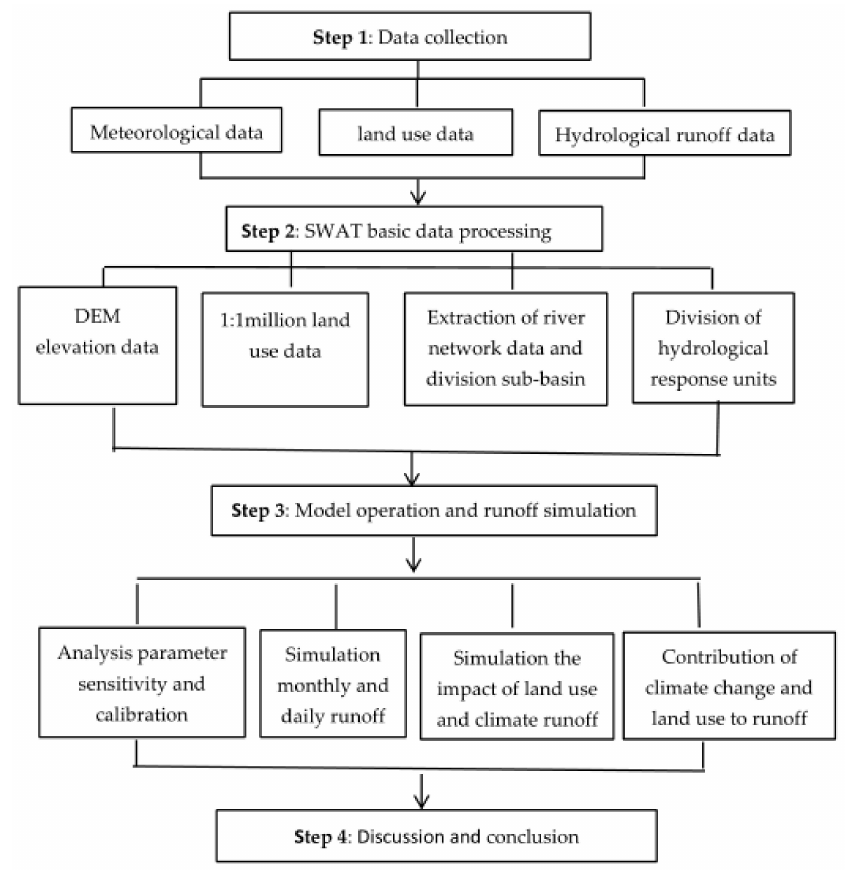
Figure 4. Technical